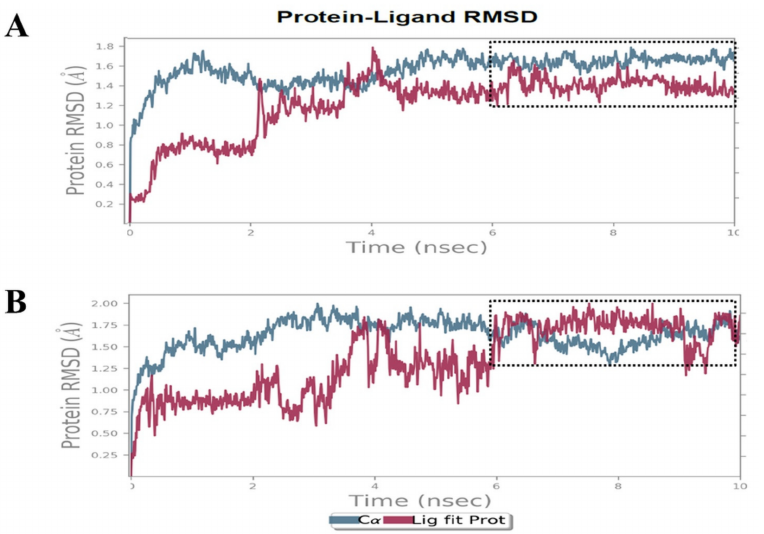
Figure 8. MD simulations predict stable and specific binding to the inhibitory site of the HDAC homolog complex by tetracosanedioic acid and TSA. Root mean square deviation (RMSD) plot of HDAC in complex with tetracosanedioic acid and TSA. The RMSD plot was recorded during 10 ns